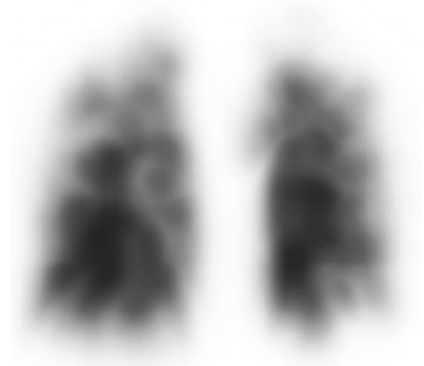
Figure 2: A lung perfusion scan showed multiple wedge-shaped perfusion defects in both lungs.